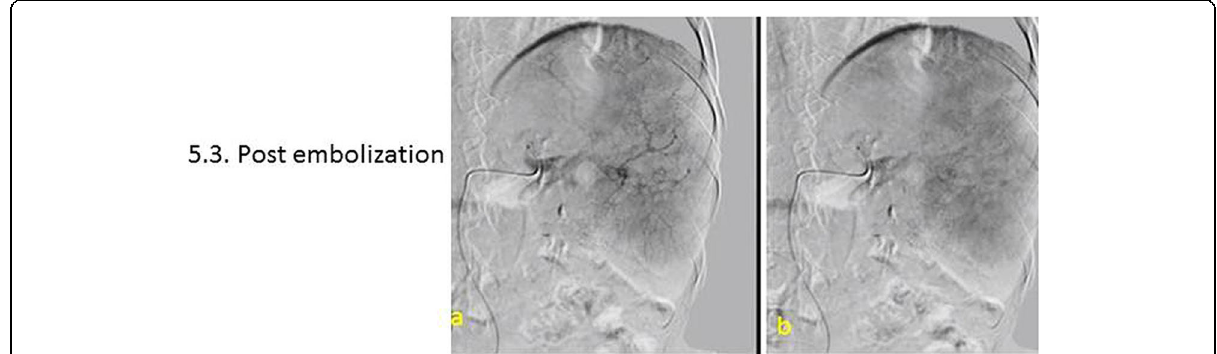
Fig. 12 Angiography after injection of more embolizing material for achieving 50% embolization